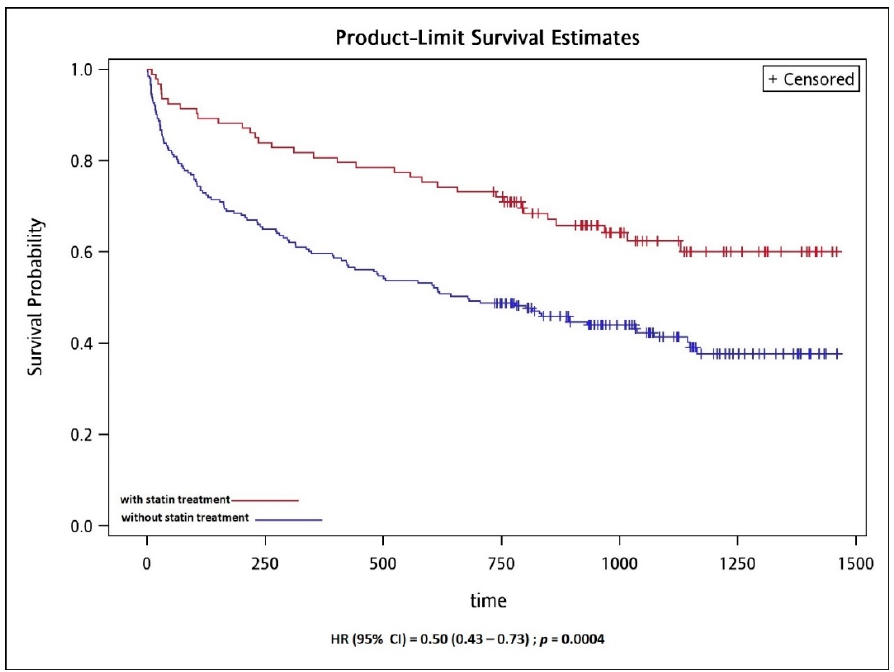
Figure 3. Kaplan - Meier survival curve of overall mortality in aged COPD patients according to use of statins.